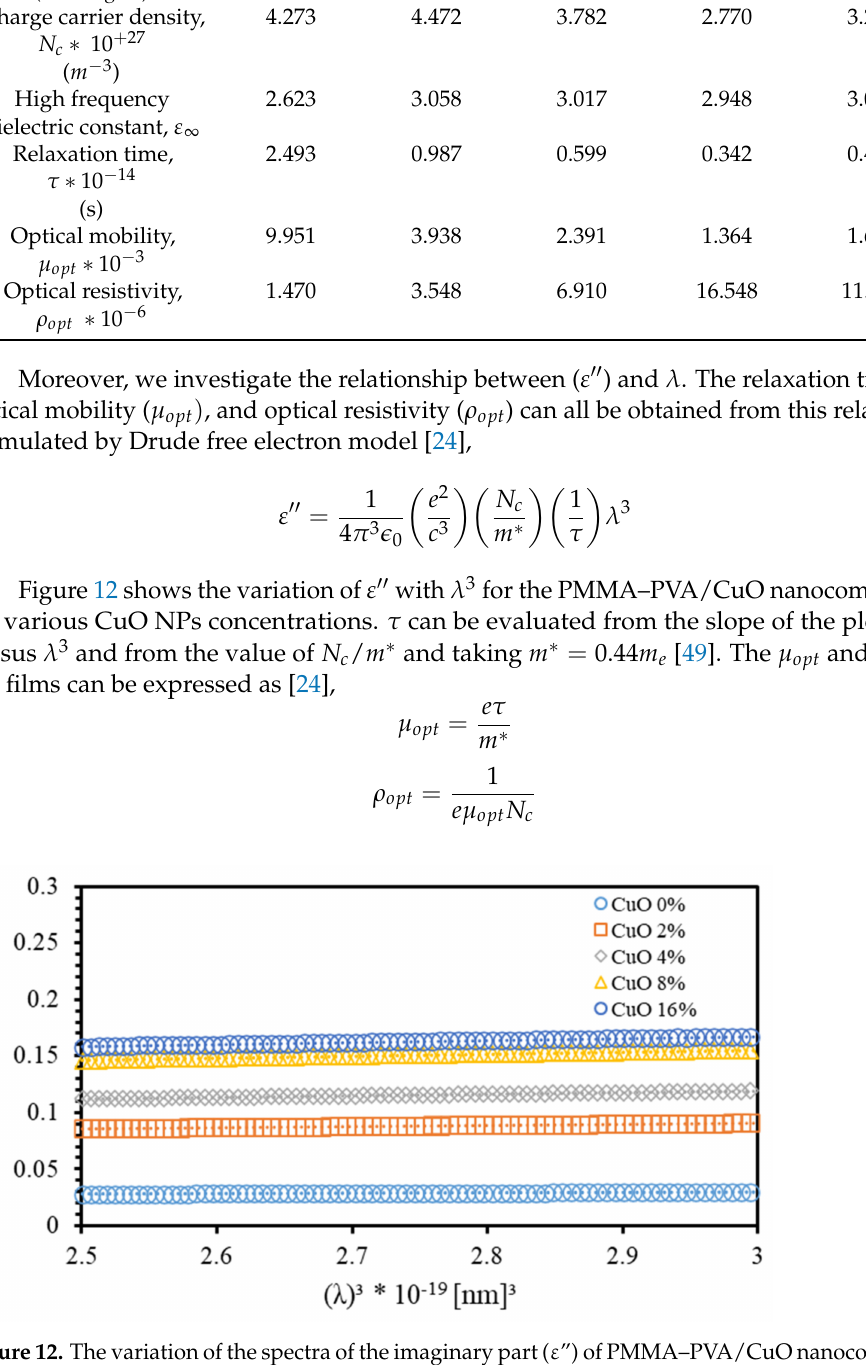
Figure 12. The variation of the spectra of the imaginary part ( ε ”) of PMMA–PVA/CuO nanocomposite thin films as a function of ( λ 3 ) for various CuO NPs